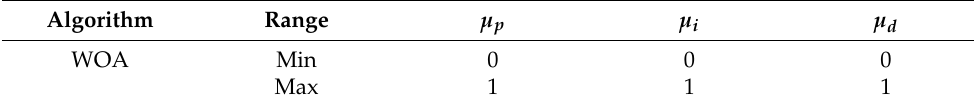
Table 4. WOA upper and lower bounds.